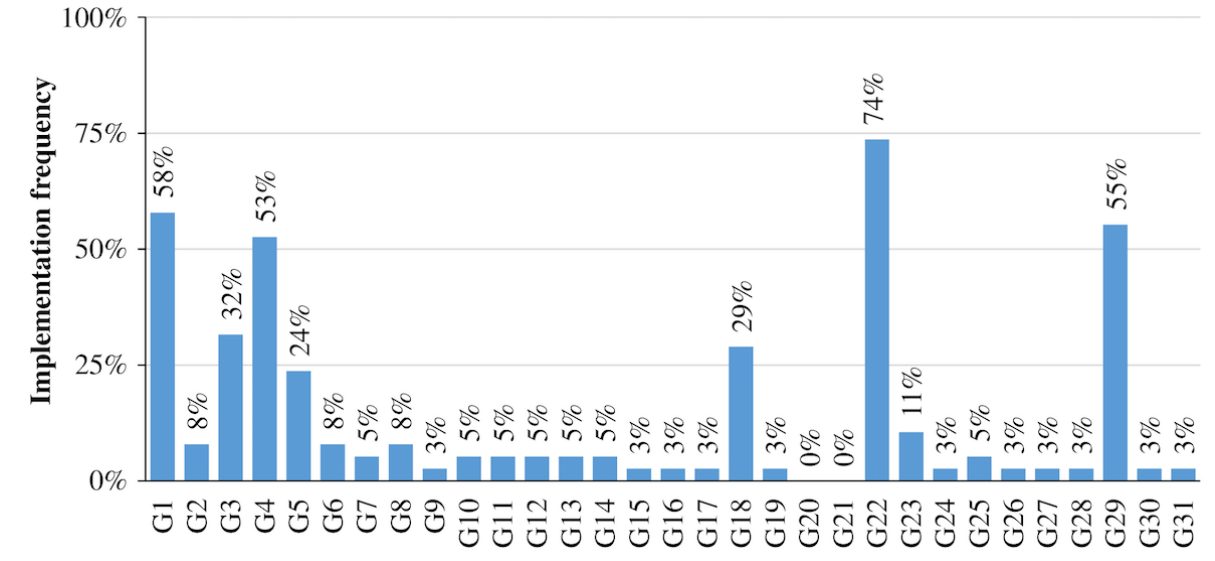
Figure 3. Percentage of asthma apps fully applying the corresponding gamification component (G1-G31; N=38).